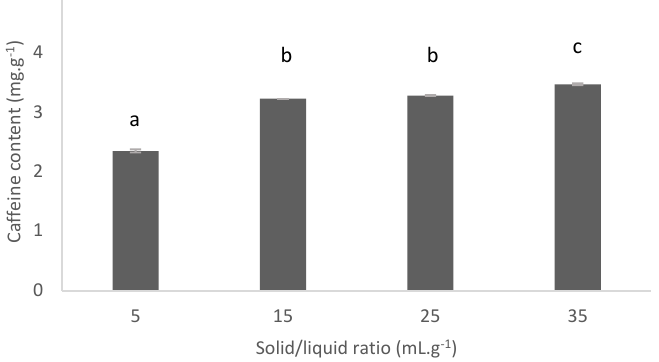
Figure 9. Influence of the solid/liquid ratio for the solid/liquid extraction of caffeine into spent coffee grounds. (Experimental conditions: 2 g of SCG for 50 mL of H 2 O/EtOH (60/40), at 60 ◦ C during 15 min, magnetically stirred). Values marked by the same letter are not significantly different ( p < 0.05) according to the Student test ( t-